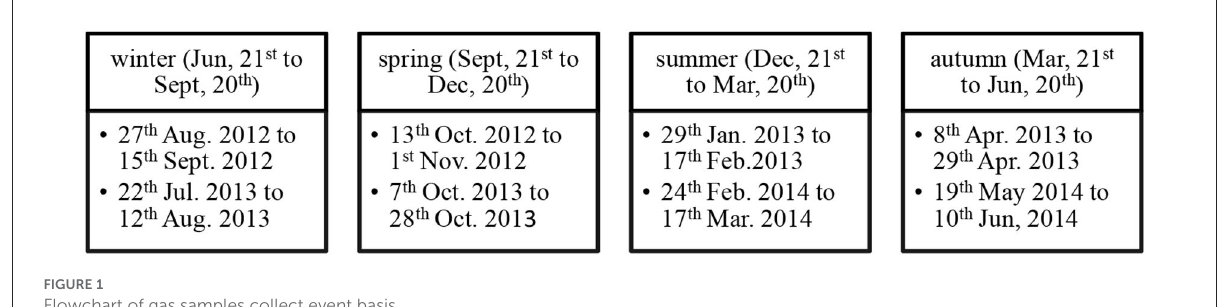
FIGURE1 Flowchart of gas samples collect event